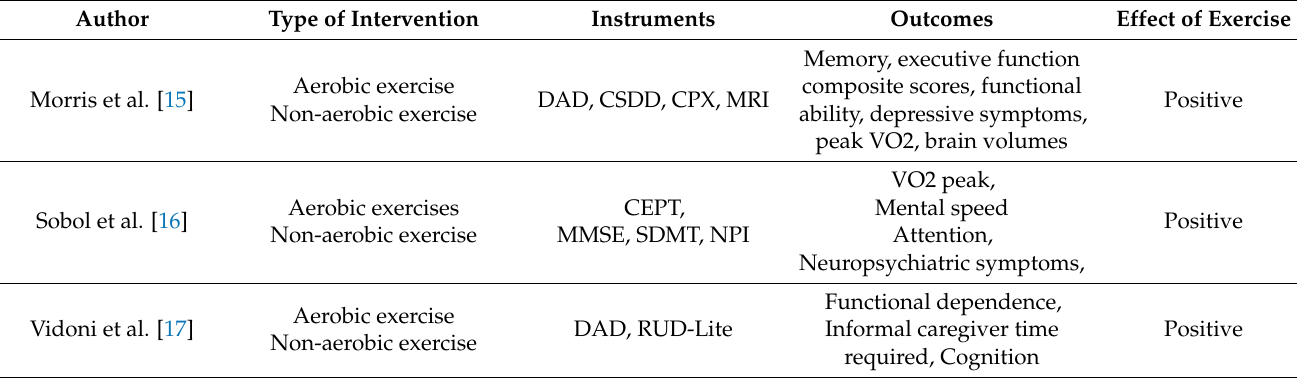
Table 1. Characteristics of the studies included in the review.